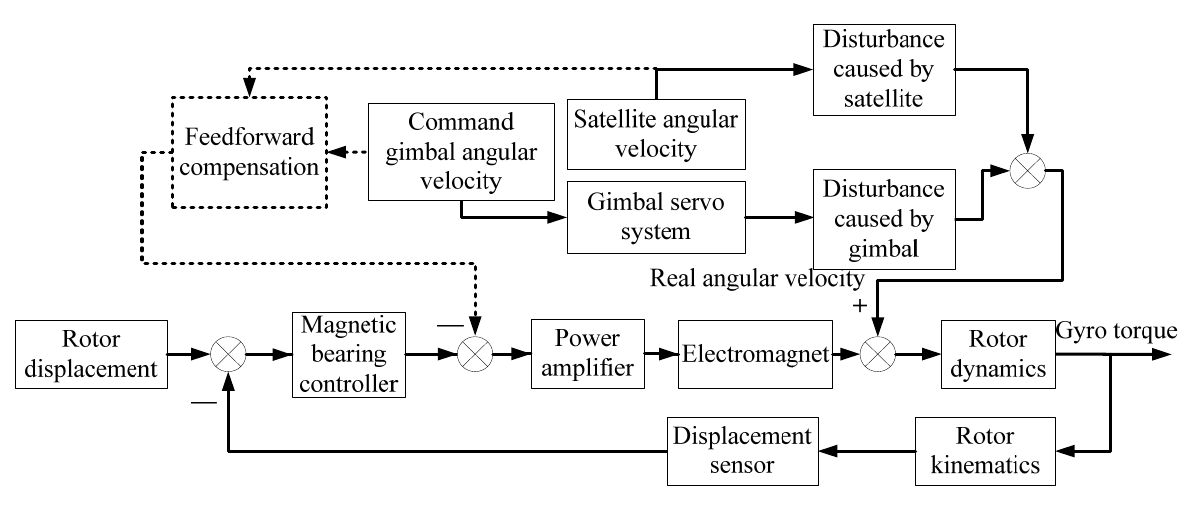
Figure 5. Sketch of the feedforward